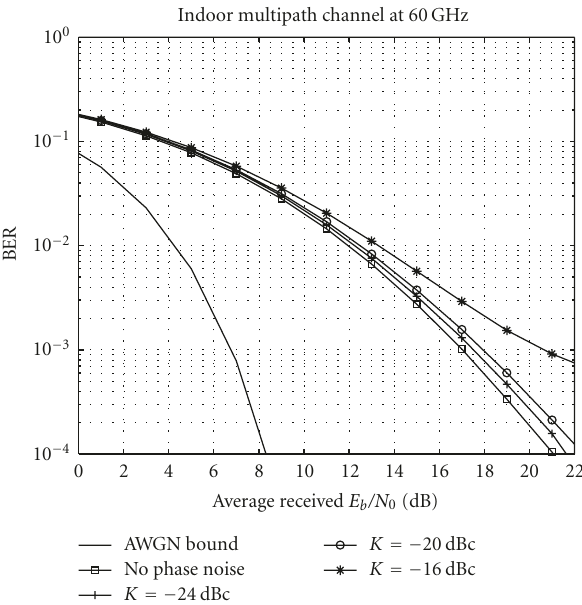
Figure 12: Impact of phase noise on BER performance of